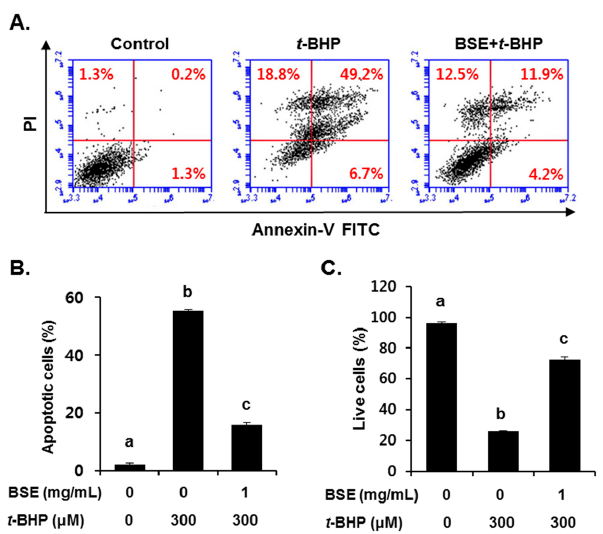
Figure 5. Inhibition of t -BHP-induced apoptotic cell death by barley sprout extract (BSE) in HepG2 cells. Cells were pretreated with BSE (1 mg/mL) for 12 h before treatment with t -BHP (300 μ M) for 18 h, followed by ( A ) FACS analysis of propidium iodide uptake and annexin V binding in non-permeabilized cells (lower-left, live cells; lower-right, early apoptotic cells; upper-right, late apoptotic cells), ( B ) quantification of apoptotic and ( C ) live cells based on 3 independent experiments. Values with different letters are significantly different by analysis of variance (ANOVA) followed by Newman–Keuls multiple comparisons test ( p < 0.05).